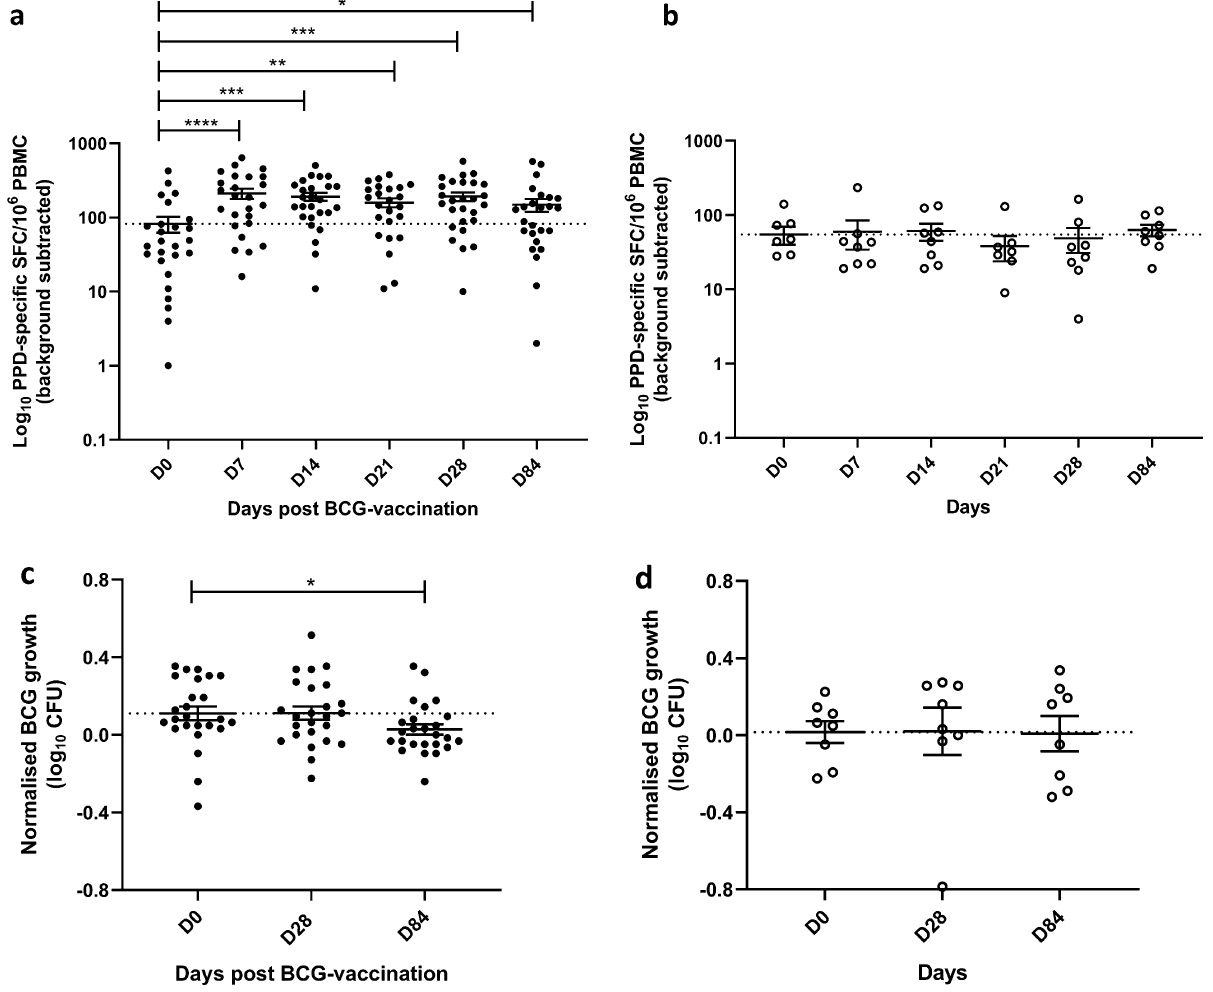
Figure 2. PPD-specific IFN-γ ELISpot responses and control of mycobacterial growth in the direct PBMC MGIA are enhanced following BCG vaccination. Samples were taken from volunteers enrolled into phases 1 and 2 combined. Healthy UK adults were randomised to receive BCG vaccination ( n = 27) or to be unvaccinated controls ( n = 8). PPD-specific IFN-γ ELISpot responses were measured at baseline and days 7, 14, 21, 28 and 84 in volunteers who received BCG vaccination ( a ) and those who were unvaccinated controls ( b ). The direct PBMC MGIA was conducted on cells and serum taken at baseline and days 28 and 84 from volunteers who received BCG vaccination ( c ) and those who were unvaccinated controls ( d ). Bars represent the mean values with the standard error of the mean (SEM); dotted lines indicate the baseline mean. For A–B, Wilcoxon tests were performed of each time-point vs. baseline. For C–D, a paired t-test was performed of each time-point vs. baseline. *Indicates a p -value of < 0.05, **indicates a p -values of < 0.005 and ***indicates a p -value of < 0.001. SFC = spot-forming